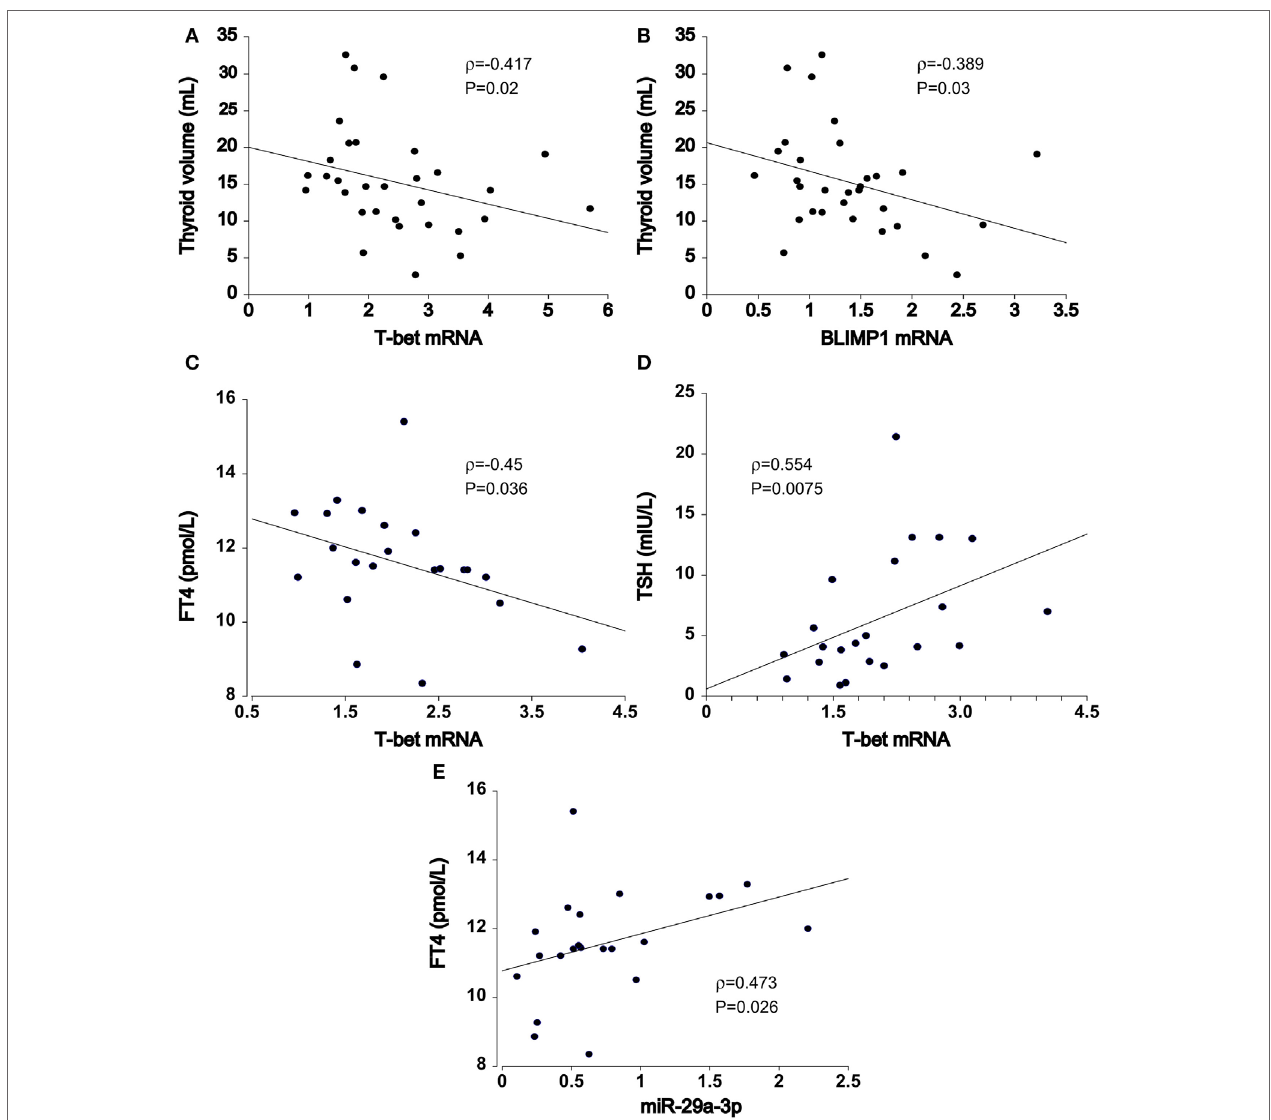
FigUre 3 | Association of T cell miRNA and mRNA transcript levels with Hashimoto’s thyroiditis (HT) clinical features. In HT patients ( n = 32), thyroid volume was inversely related to increments in (a) T-bet and (B) BLIMP1 transcript abundance in peripheral blood T cells. In untreated HT patients (euthyroid + hypothyroid, n = 22), upregulated (c) T-bet expression was associated with declining FT4 and (D) increasing TSH serum levels. (e) miR-29-3p expression exhibited opposite, positive effects in relation to serum FT4 levels. Transcriptional changes of mRNA and miRNA were measured by quantitative real-time PCR and normalized against TBP and U6snRNA,